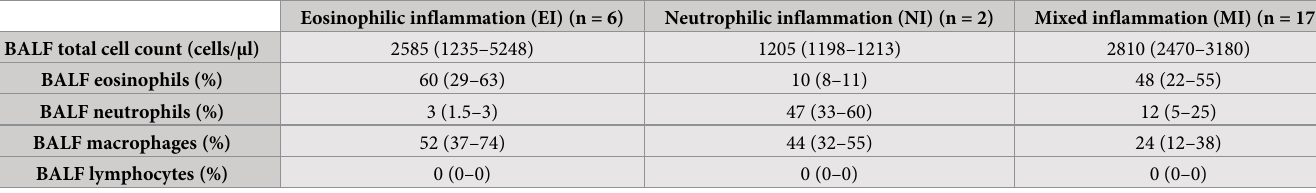
Table 3. Cytologic differentiation of bronchoalveolar lavage fluid (BALF) from cats with FLAD. Eosinophilic inflammation (EI) (n =